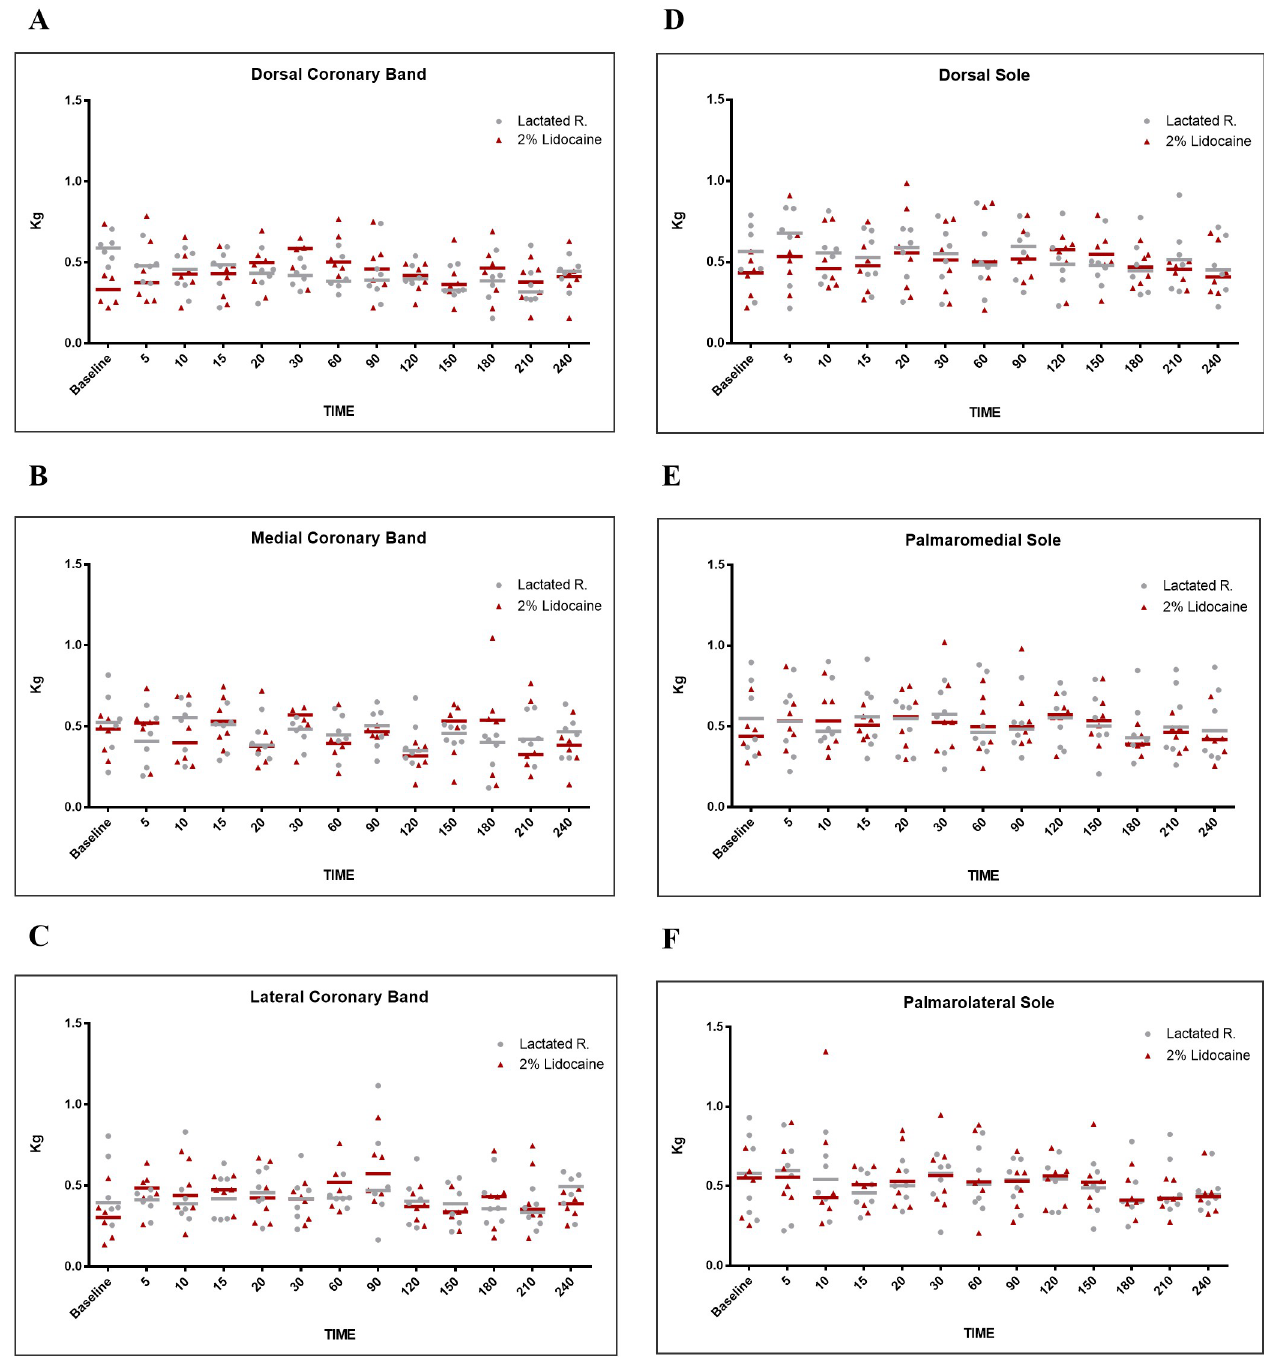
Fig 2. Graphical representation of mechanical nociceptive threshold (MNT) values, with mean values and median in kilograms (kg). Evaluation of coronary band: (A) dorsal, (B) medial, (C) lateral. Evaluation of sole borders: (D) dorsal, (E) palmaromedial, (F) palmarolateral, in healthy equine forelimbs, injected into navicular bursa with lactated Ringer’s solution or 2% lidocaine.